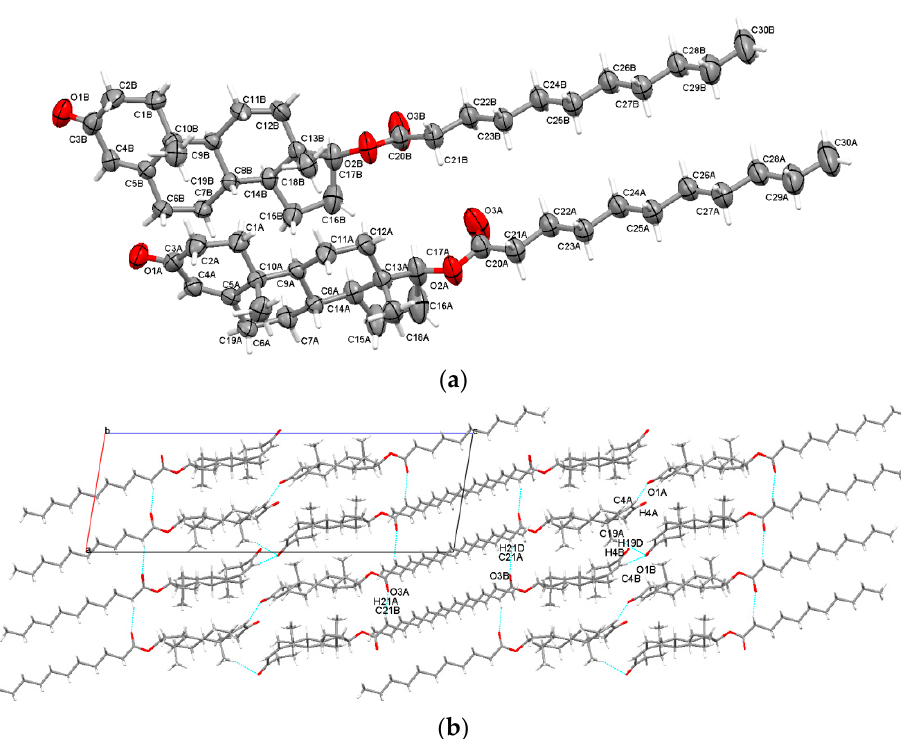
Figure 5 . Asymmetric unit of TUnd presenting non-hydrogen atoms at 50% probability level ( a ); overall packing viewed along the b-axis ( b ) .